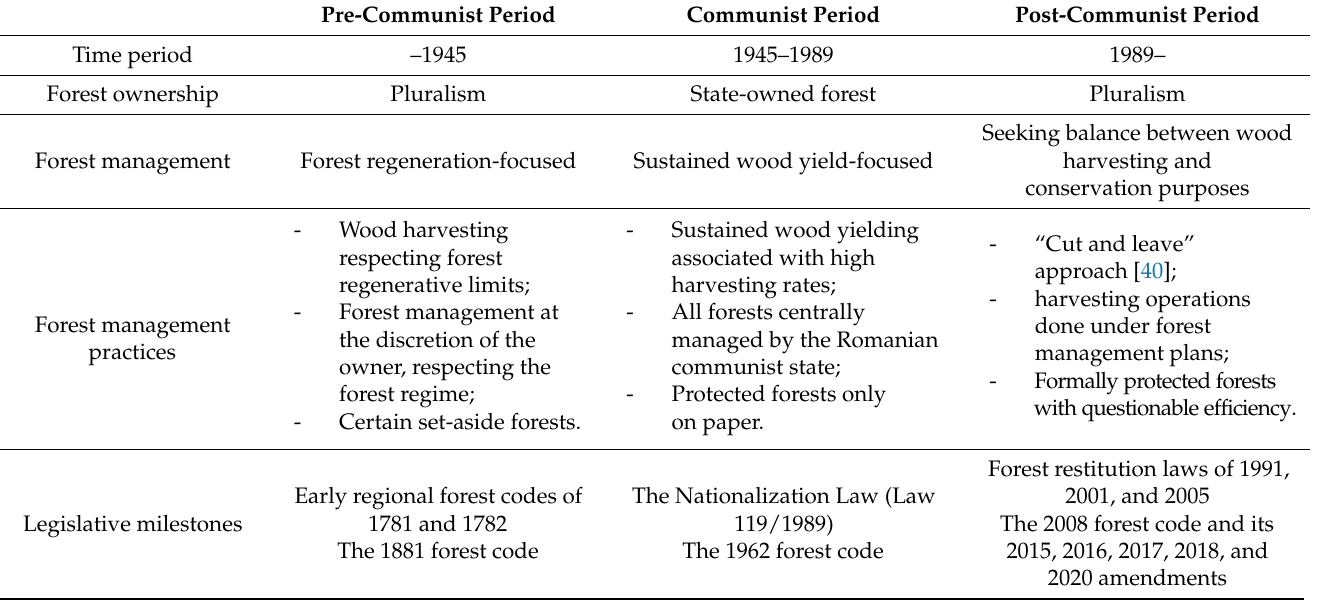
Table 1. Particularities of Romanian forest ownership and management during the analyzed periods. Pre-Communist Period Communist Period Post-Communist